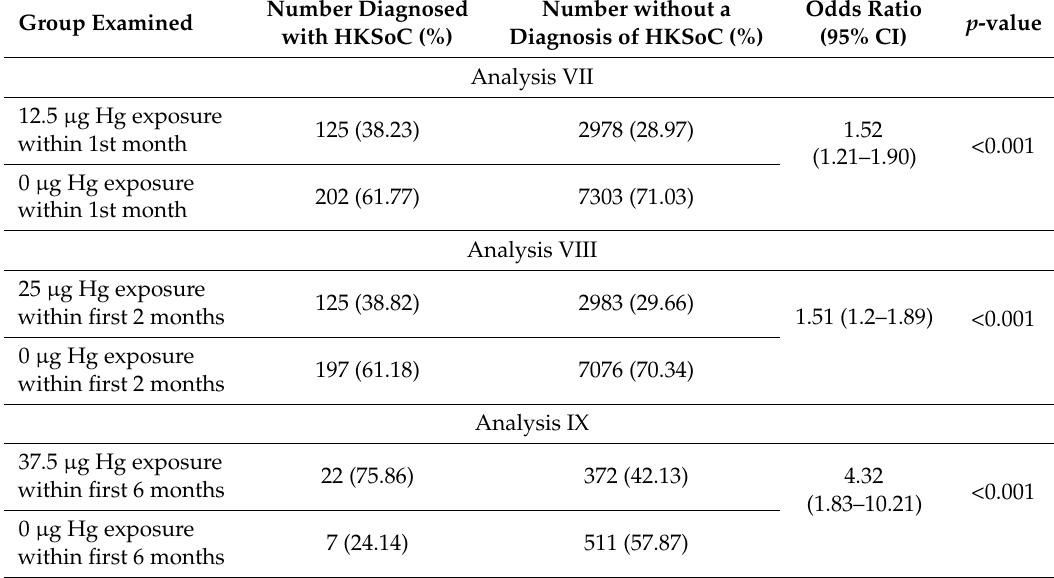
Table 4. A summary of organic-mercury exposure from Thimerosal-preserved hepatitis B vaccine administration between female cases diagnosed with hyperkinetic syndrome of childhood (HKSoC) and female controls within the Vaccine Safety Datalink